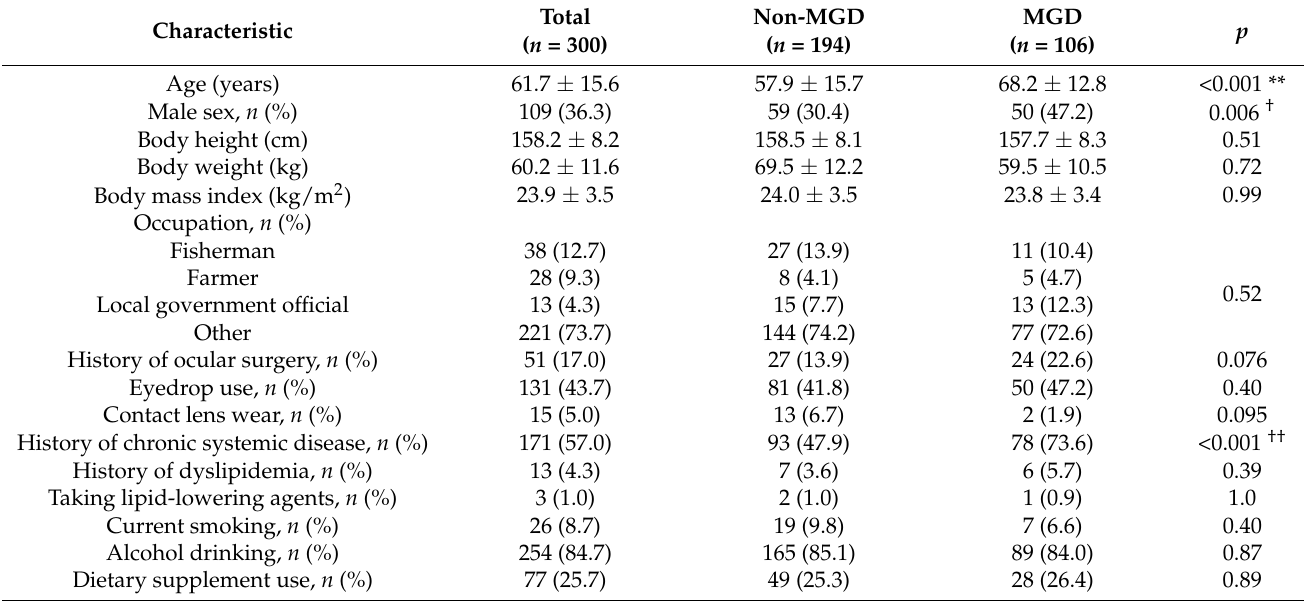
Table 1. Characteristics of adult subjects with or without meibomian gland dysfunction (MGD) in the Hirado–Takushima study. Characteristic